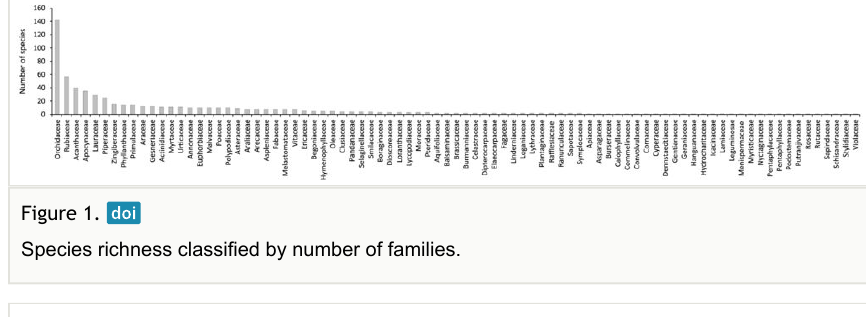
Figure 1. Species richness classified by number of families.